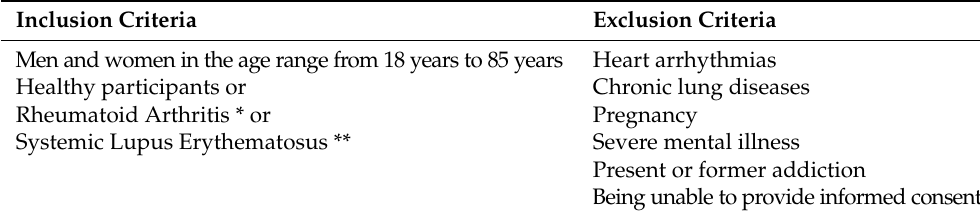
Table 1. Inclusion and exclusion criteria. * Rheumatoid Arthritis according to the American College of Rheumatology (1987 or 2010) or European League Against Rheumatism (2010) classification criteria [28]. ** Systemic Lupus Erythematosus according to American College of Rheumatology classification criteria for SLE [29] or Systemic Lupus International Collaborating Clinics Classification [30].